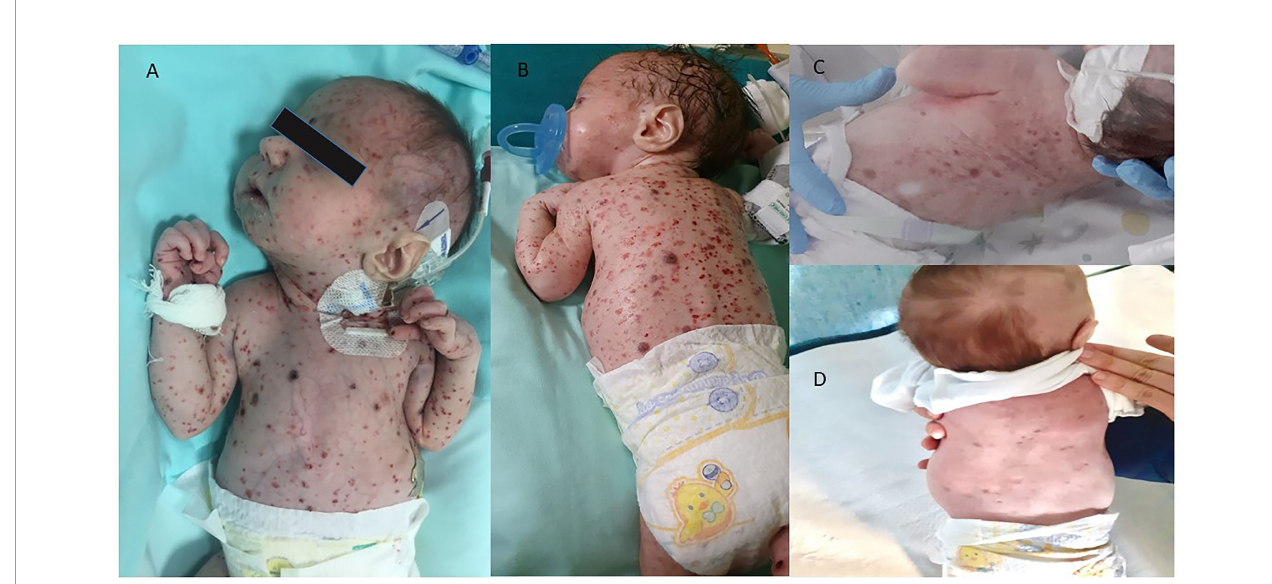
FIGURE 1 | Skin response (A, B) skin at diagnosis, (C) skin after 2 week of vemurafenib treatment, (D) skin after 1 month of vemurafenib